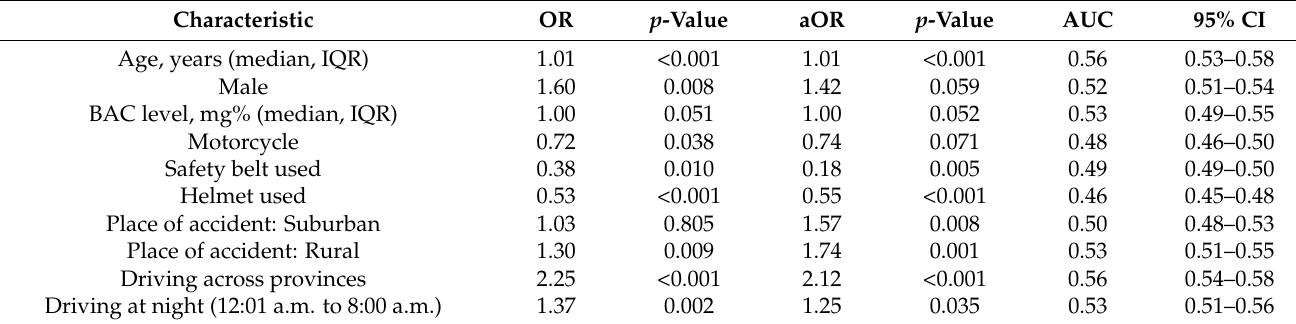
Table 2. The association between candidate predictors and death from road-traffic